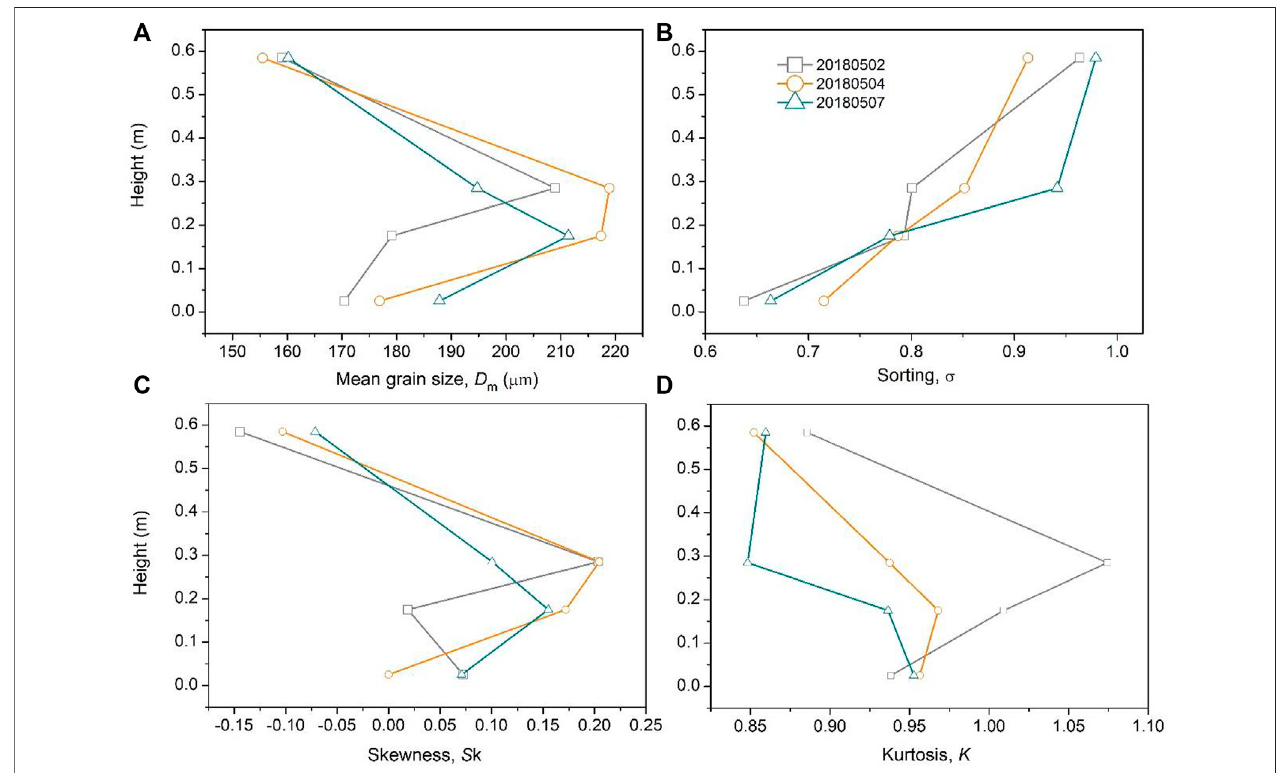
FIGURE 5 | Variation of the grain-size statistics with height during the three transport events. (A) Mean grain size, (B) Sorting, (C) Skewness, (D) Kurtosis.